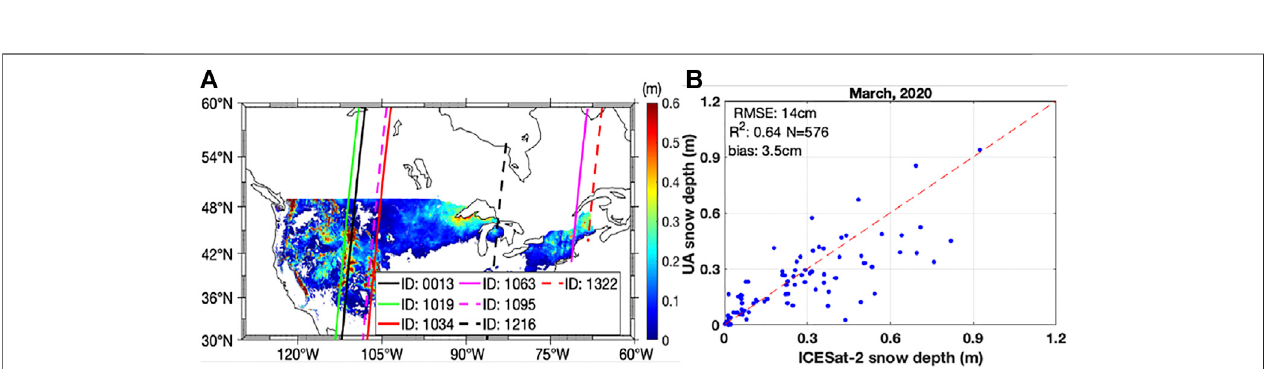
FIGURE7|(A) ICESat-2groundtracks(lines)labeledwithtrackRGTsoverlandsurfaceinMarch2020,thebackgroundcoloristhesnowdepthinmetersfromUA daily4 km gridded snow product on 27March 2020. (B) Scatter plots between ICESat-2 and UA daily gridded snow depths inMarch 2020.The distancesbetween the ICESat-2 footprints and the center of gridded pixels are less than 50